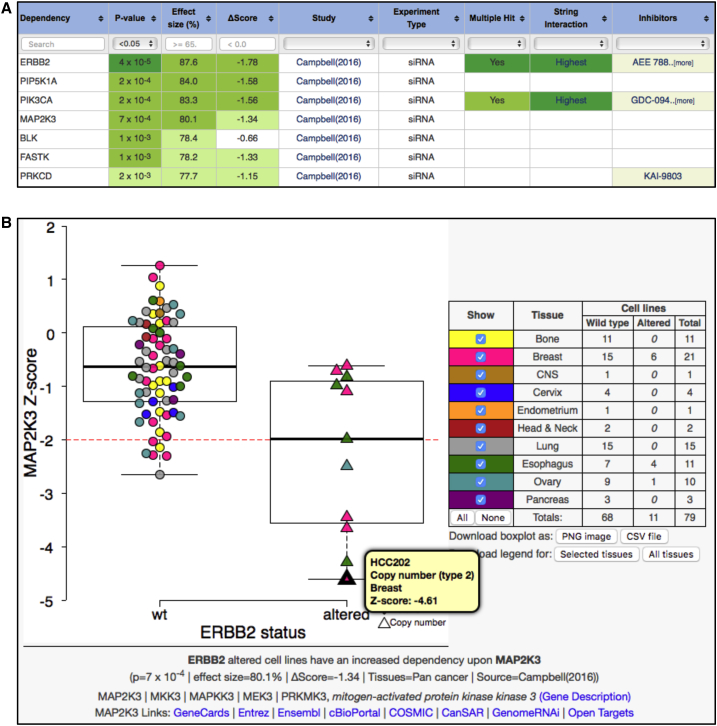
Genetic Dependency Exploration and Visualization(A) The principle view of the database. Each row represents a gene identified as a dependency associated with ERBB2 amplification in Campbell et al. (2016) across all tumor types (Pan cancer). Columns display experimental details along with the p value, common language effect size, and difference in median sensitivity score for each dependency. Genes identified as dependencies in multiple datasets are indicated in the Multiple Hit column. Genes with a known functional relationship to the driver gene (e.g., PIK3CA) are indicated in the String Interaction column, and drugs known to inhibit the target gene are indicated in the Inhibitors column. Toggles/search boxes permit easy filtering of interactions, e.g., to select only those genes with an associated inhibitor available. See also Figure S1 and the tutorial in Methods S1.(B) Example boxplot showing an increased sensitivity of ERBB2-amplified cell lines to inhibition of MAP2K3. Each data point represents the sensitivity of a particular cell line to RNAi reagents targeting MAP2K3. Cell lines are grouped according to ERBB2 amplification status with the wild-type group on the left and amplified group on the right. Cell lines are colored according to site of origin and toggles on the right permit the hiding/showing of cell lines from specific sites. Hovering over a given data point provides the cell line's name, the primary site, and the score associated with the RNAi reagent in that cell line. An overlapped box-whisker plot displays the interquartile range and the median for each group. High-resolution PNG images for each boxplot can be downloaded along with a CSV file containing all of the data presented in the boxplot. Links to the target gene (MAP2K3) on external websites are provided at the bottom of the plot.